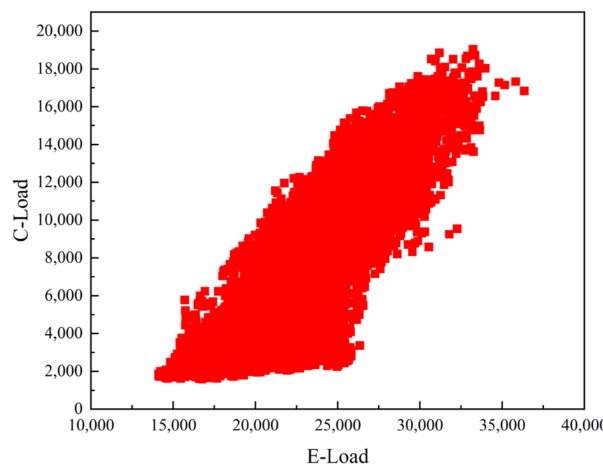
Figure 7. Correlation between electrical load and cooling